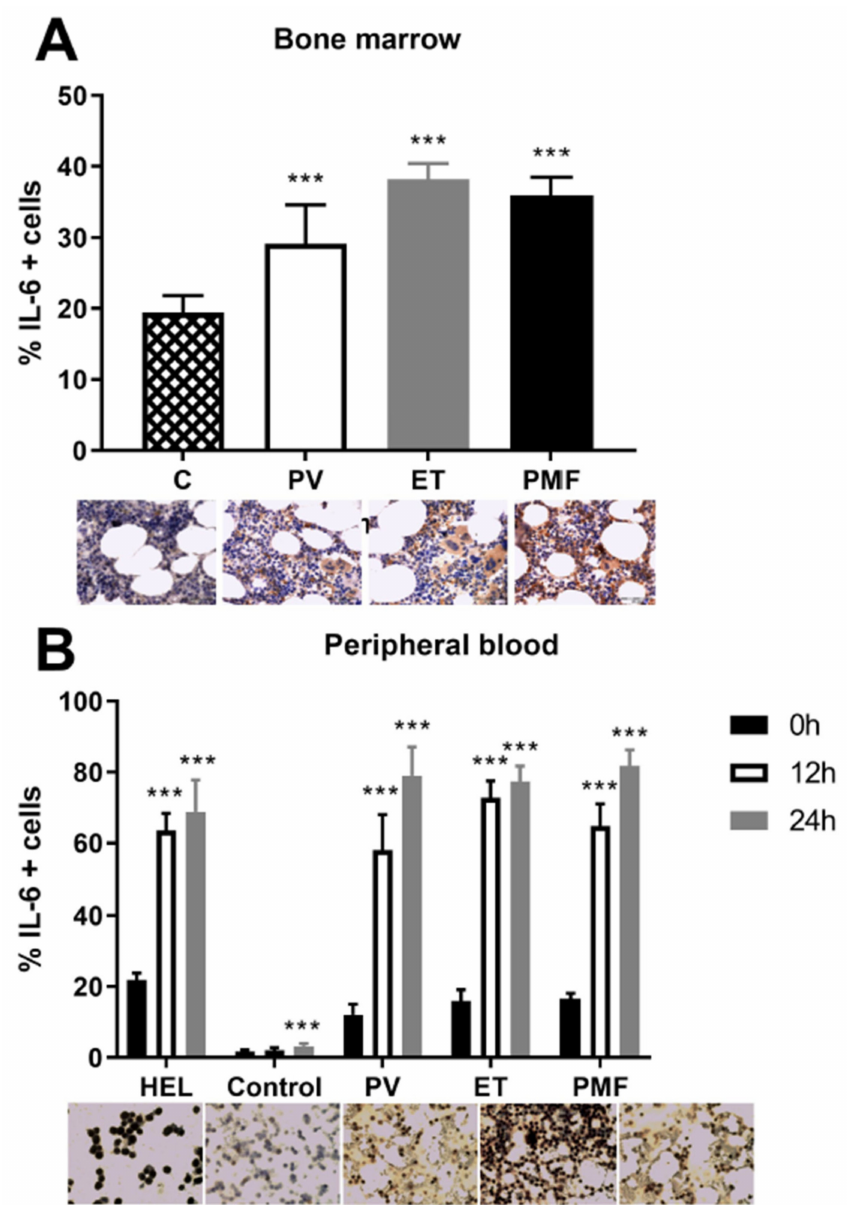
Figure 6. Percentage of IL-6 positive cells in ( A ) bone marrow of polycythemia vera (PV), essential thrombocythemia (ET), and primary myelofibrosis (PMF) determined by immunohistochemistry (IHC, *** p < 0.001 vs. control) and ( B ) human erythroleukemic (HEL with JAK2V617F) cells, periph- eral blood derived MNC of healthy controls, PV, ET, and PMF treated for 12 and 24 h with 10 µ g/mL VEGF determined by immunocytochemistry (ICC). ICC slides correspond to columns in graph, after 24 h of treatment by VEGF. *** p < 0.001 vs. non-treated cells. Values are mean ± SEM ( n =